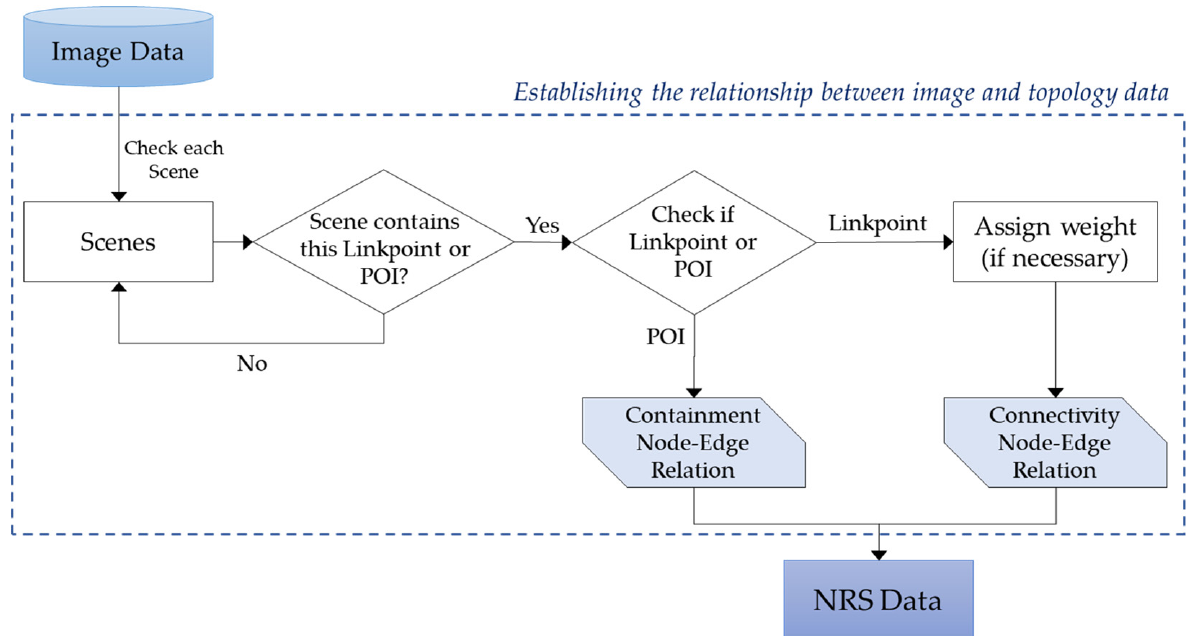
Figure 9. Extracting the NRS data from the image reference data.